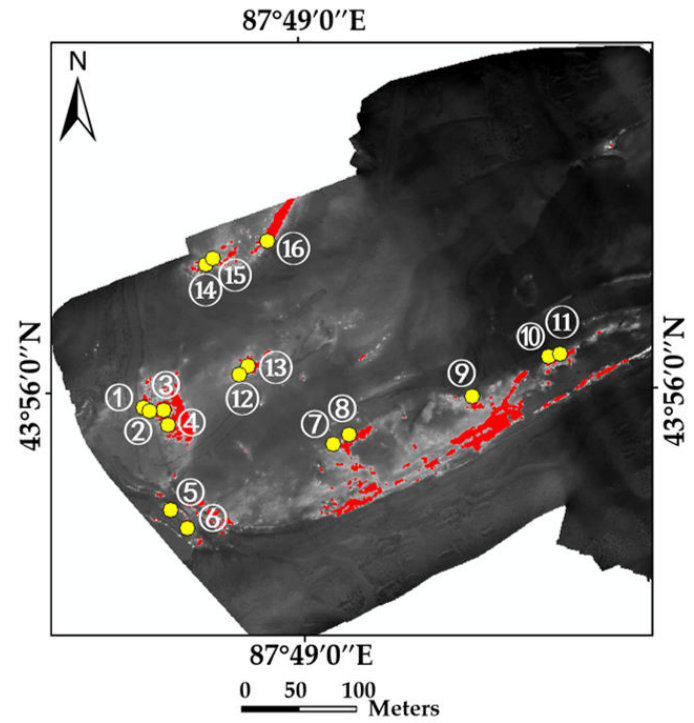
Figure 11. Location of data points measured in the field.